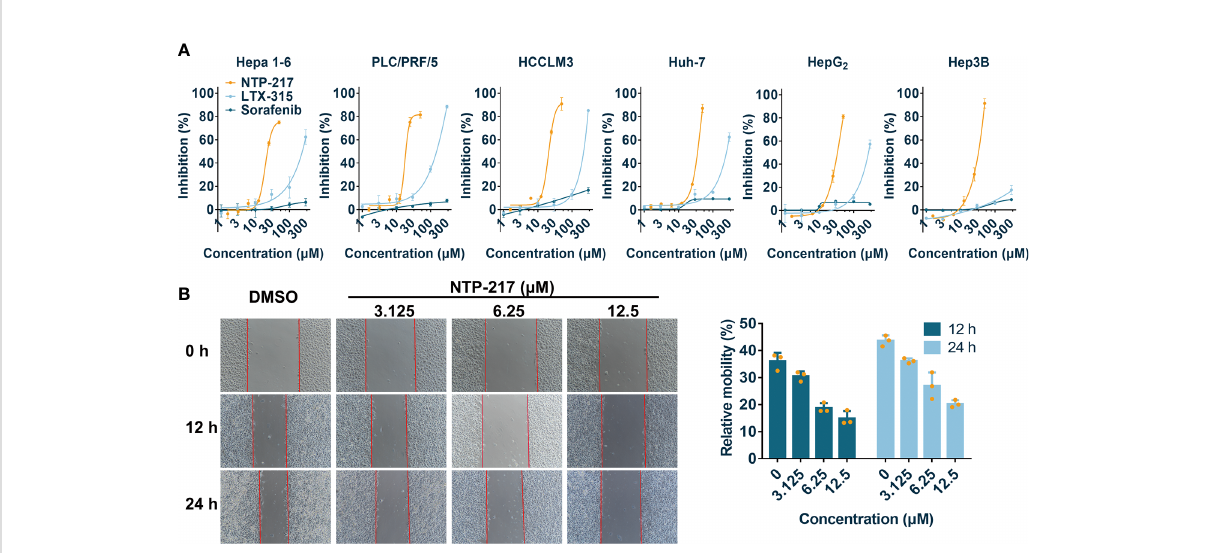
FIGURE 1 Cytotoxicity and anti-migration ability of NTP-217 in hepatoma cells. (A) Inhibition rates of hepatoma cells after treatment with NTP-217, LTX- 315 or sorafenib at various concentrations (1.5625, 3.125, 6.25, 12.5, 25 and 50 m M for NTP-217, or 1, 3, 10, 30, 100 and 300 m M for LTX-315 and sorafenib) for 4 h (n=3). (B) Anti-migration effect of different concentrations of NTP-217 against Hepa 1-6 cells (left panel; objective magni fi cation, x4) and quanti fi cation of the anti-migration ability (right panel). Data are expressed as the mean ± SD